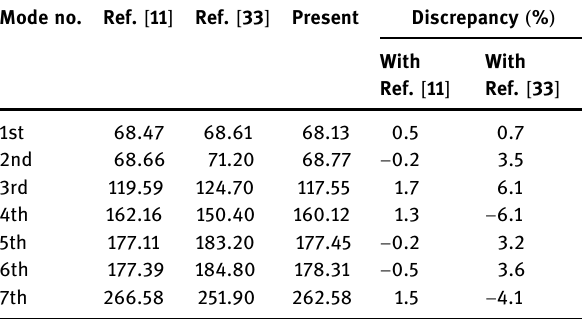
Table 2: Comparison of natural frequencies ( Hz ) of sti ff ened